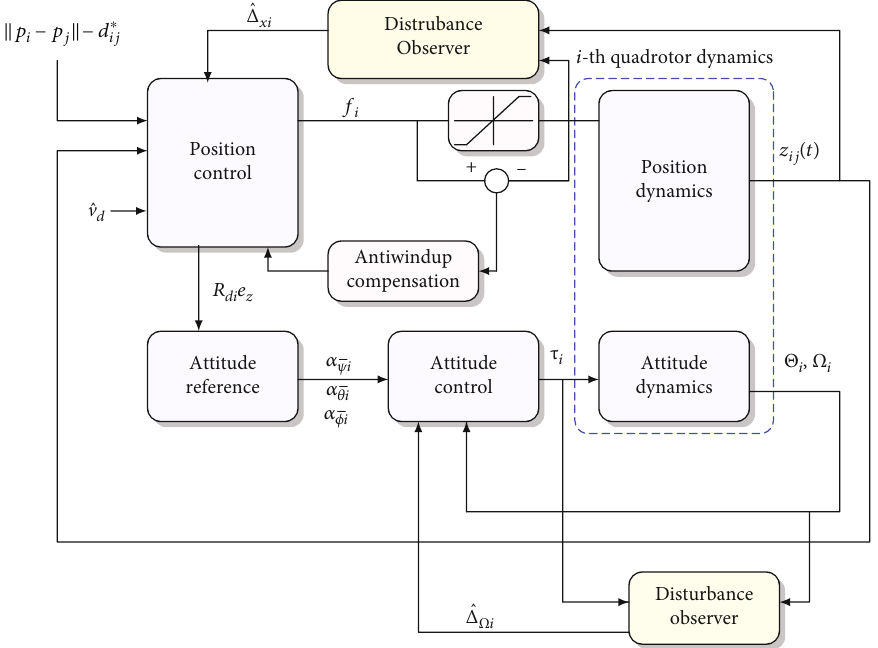
Figure 3: Block diagram of the decentralized distance-based formation control.